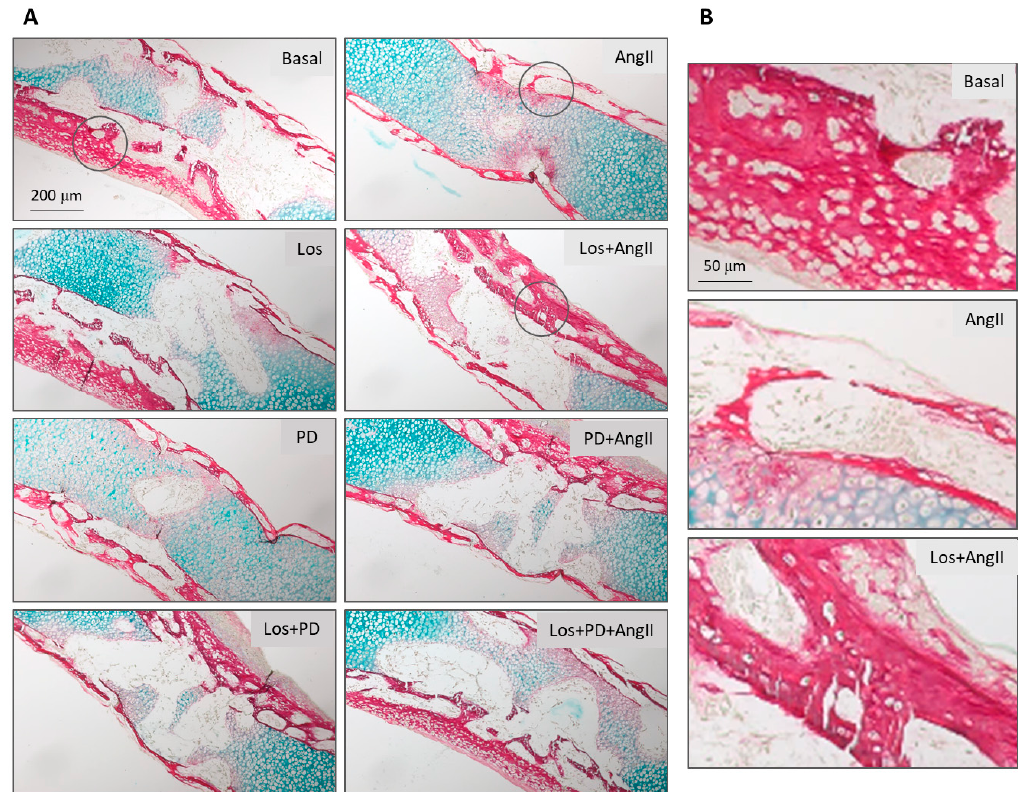
Figure 3. Histological images of the diaphyseal region from ED11 chick femurs stained with Alcian blue and Picrosirius red for glycosaminoglycan and collagenous matrix visualization, following 11-day organotypic culture in conditions of AngII/AT1R/AT2R axis modulation. ( A ): Low magnification images illustrating all tested conditions; ( B ): high magnifi- cation images for basal conditions, exposure to AngII and AT1R blockade prior to the addition of AngII. Los: Losartan; PD: PD123319. Scale bar = 200 µ m ( A ) and 50 µ m ( B